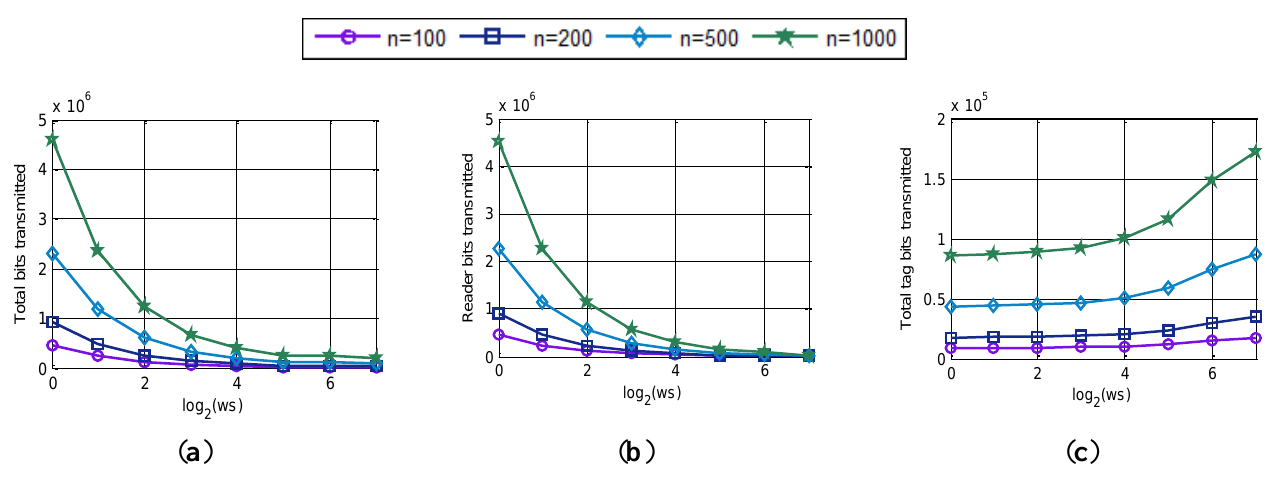
Figure 11. Simulated results of: ( a ) total bits transmitted; ( b ) reader bits transmitted and ( c ) total tag bits